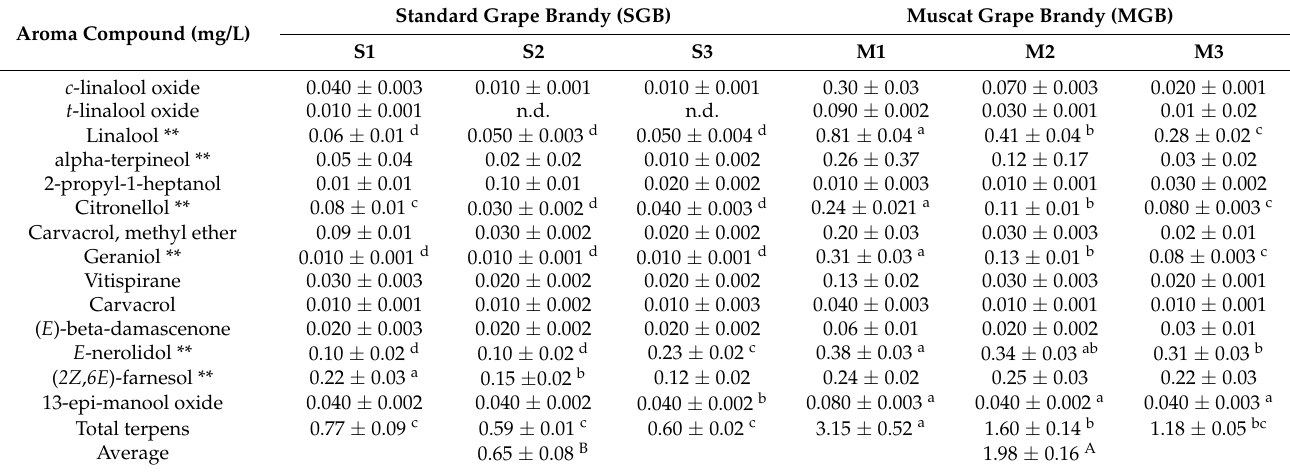
Table 3. Concentration of terpenes in standard and Muscat grape brandies in mg/L